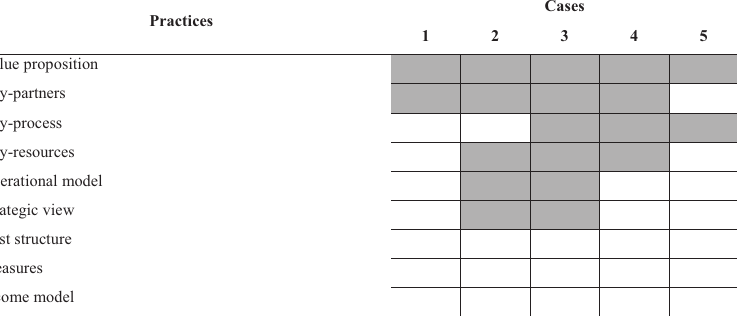
Figure 2. Practices used by